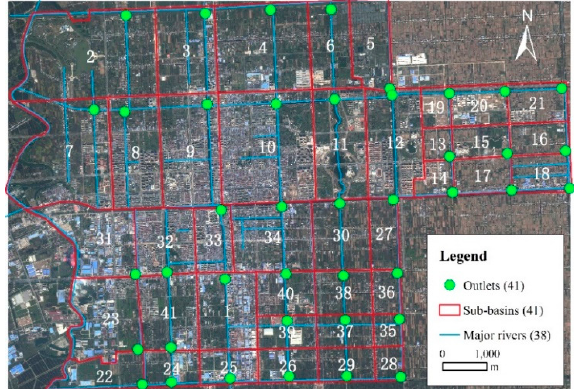
Figure 3. True-colour image with the distribution of sub-basins in the study area.